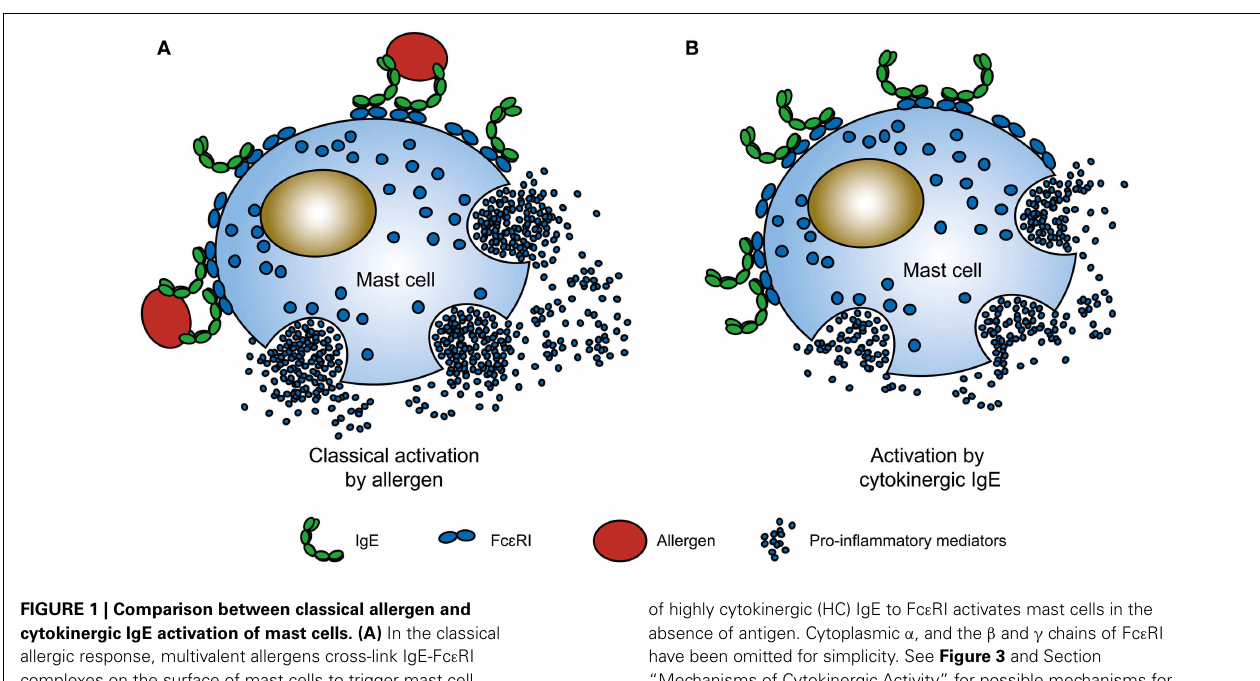
FIGURE 1 | Comparison between classical allergen and cytokinergic IgE activation of mast cells. (A) In the classical allergic response, multivalent allergens cross-link IgE-Fc ε RI complexes on the surface of mast cells to trigger mast cell activation, e.g., mast cell degranulation. (B) In contrast, the binding